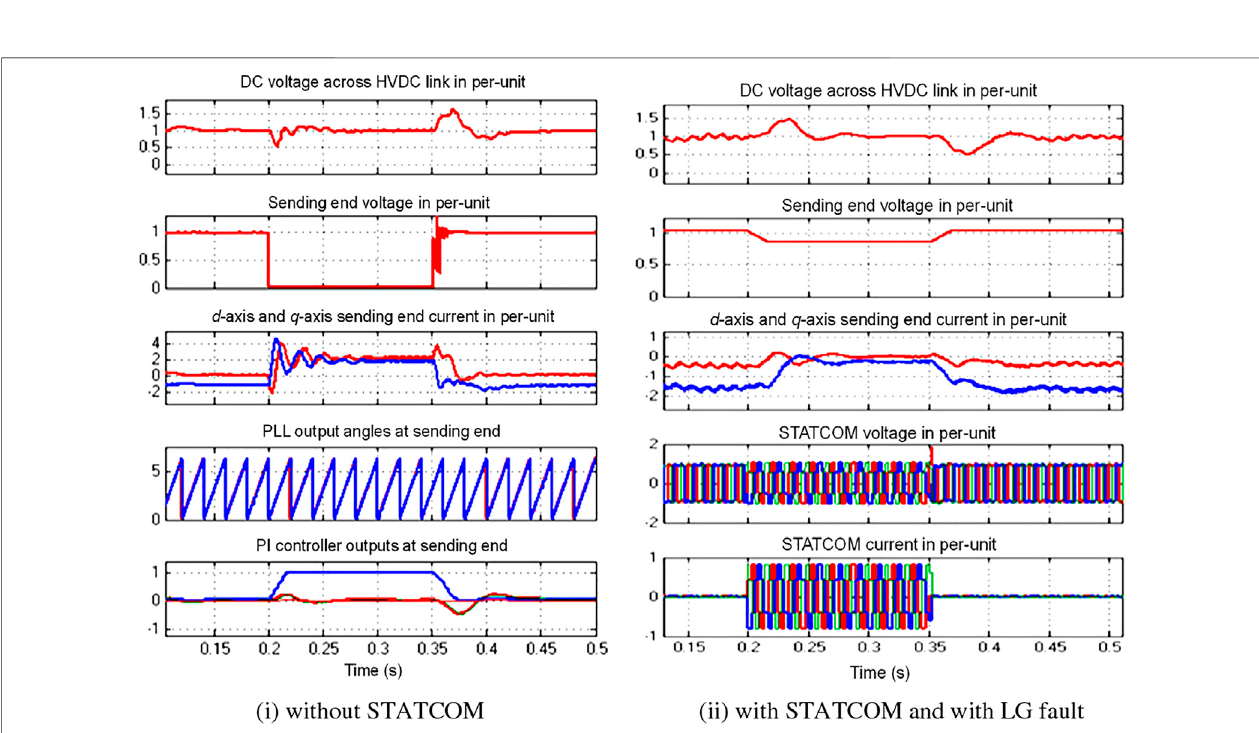
FIGURE10| HVDCdc-linkvoltage,RMSvalueofSEsideacvoltage,dandqaxiscurrentsatSEside,PLLangles,andPIcontrolleroutputs. (i) WithoutSTATCOM. (ii) With STATCOM and with LG fault.